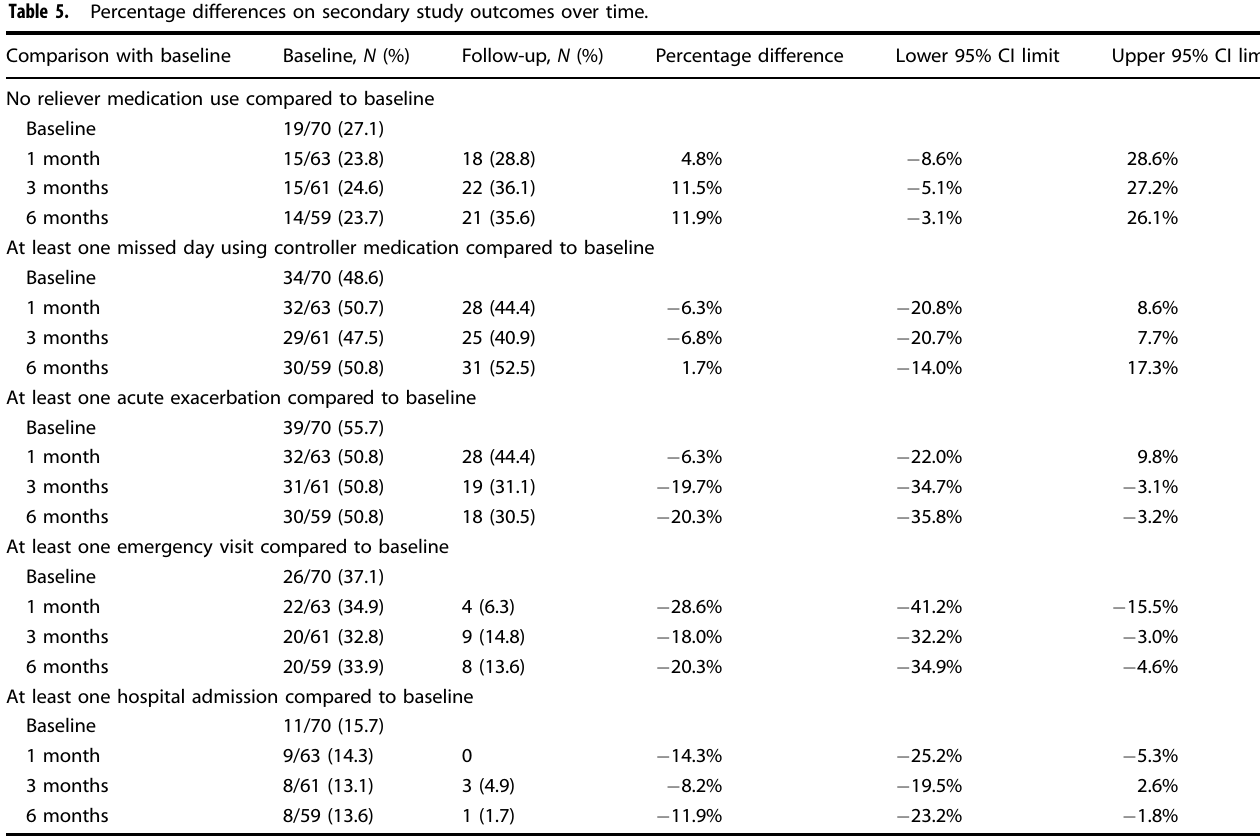
Table 5. Percentage differences on secondary study outcomes over